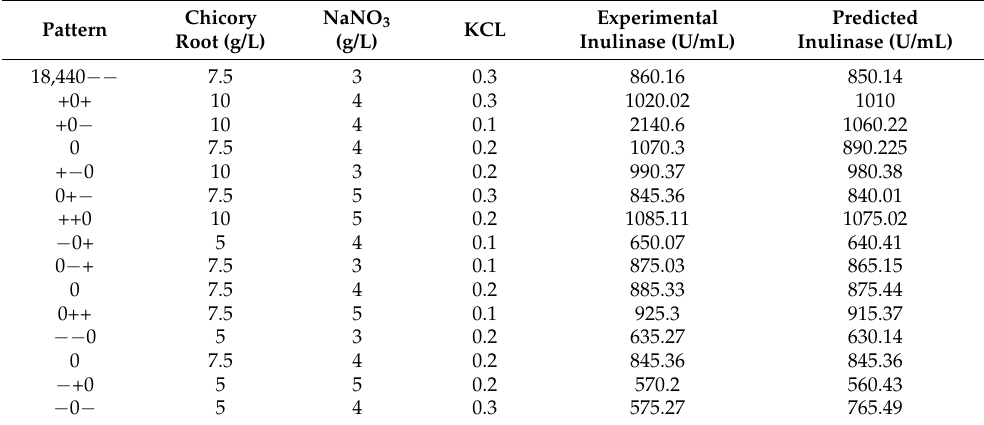
Experimental Inulinase (U/mL)